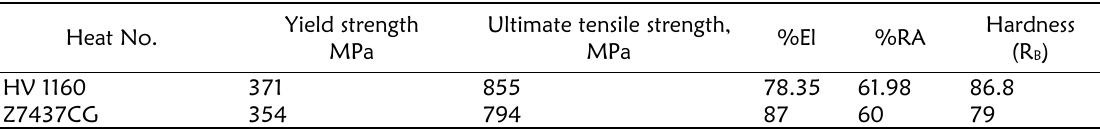
Table 2: Ambient-Temperature Tensile